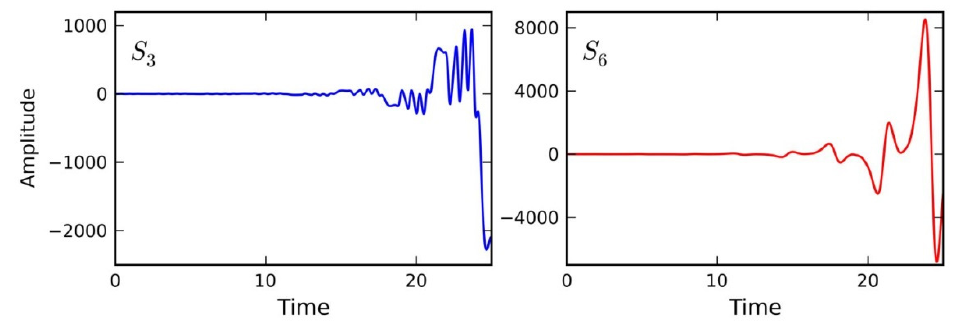
Figure 1. Sensitivity functions of the variables z and Z to the parameter r , which were calculated for strong coupling between fast and slow systems ( 𝑐 = 0.8 ).